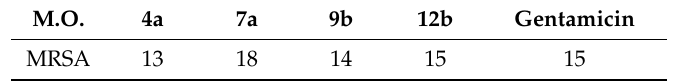
Table 2. The zones of inhibition (mm) against methicillin-resistant Staphylococcus aureus (MRSA). M.O. 4a 7a 9b 12b Gentamicin MRSA M.O: microorganism.